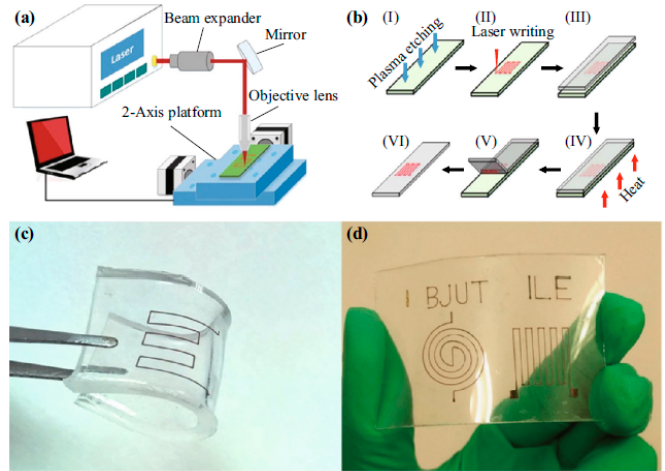
Figure 6. Schematic diagram of the ( a ) experimental setup and ( b ) steps of fabrication for developing the sensors. The steps of fabrication included plasma etching, laser writing, coating, curing, peeling, and overlay of the specified processing materials to develop the sensors. Images of the sensors consisting of ( c ) copper electrode and PDMS substrate and ( d ) Spider and zigzag electrode designs on the flexible substrates [81] .